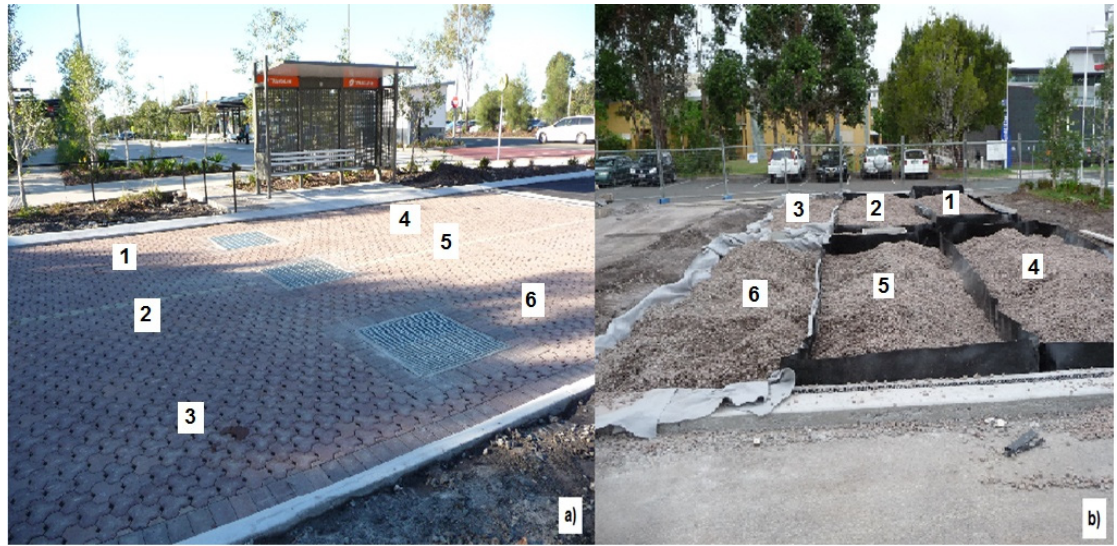
Figure 2. Test locations: ( a ) after construction; and ( b ) during construction, showing the six separate treatment